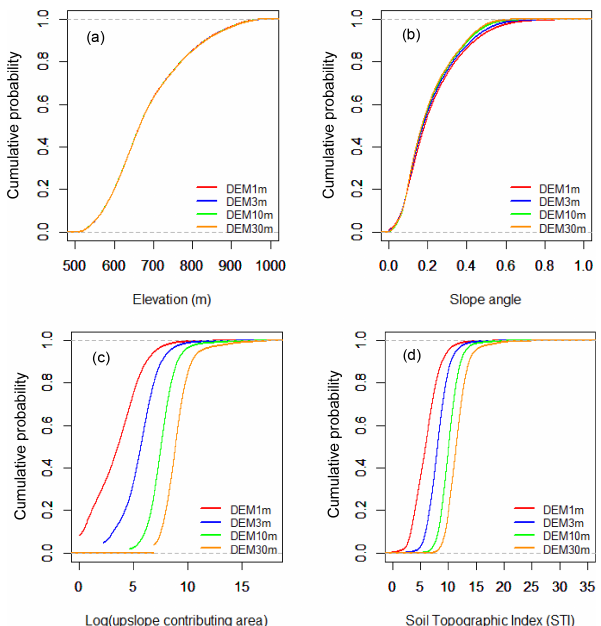
Figure 3. Difference in cumulative probability distribution of ele- vation, slope, upslope contributing area and topographic index be- tween different DEM